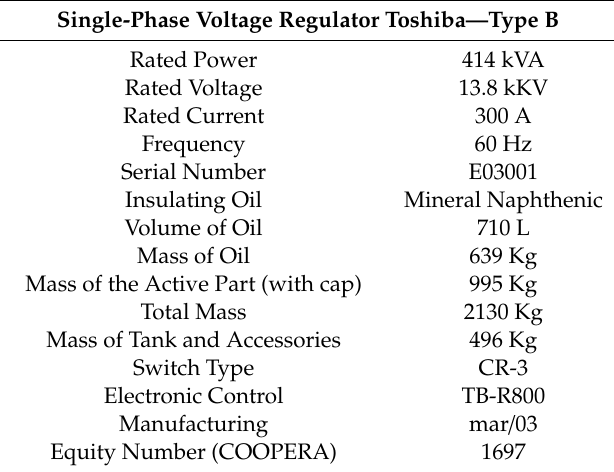
Table 1. Toshiba Voltage Regulator